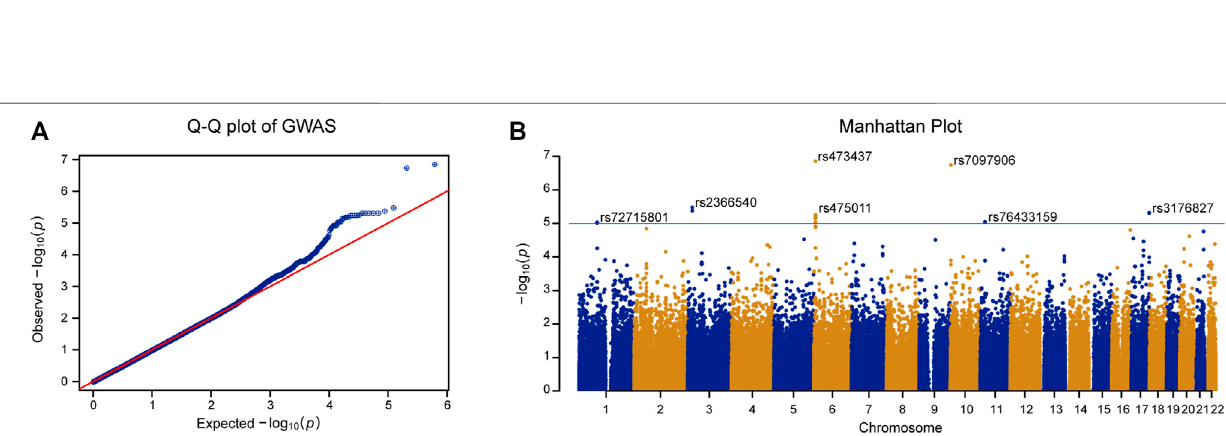
FIGURE 1 | Correlations among different phenotypes in PMO patients. (A) Heatmap of correlation coef fi cients between pairs of phenotypes. Each box represents the Pearson ’ s r 2 betweenthe column and row phenotypes. The shade ofred indicates the valueof r 2 . (B) Heatmap of correlation p valuesbetweenpairs of phenotypes. Eachboxrepresentsthelog-transformed p valueofthecorrelationbetweenthecolumnandrowphenotypes.BMD:bonemineraldensity;YSM:yearssincemenopause; BMI: body mass index; T2D; type 2 diabetes.